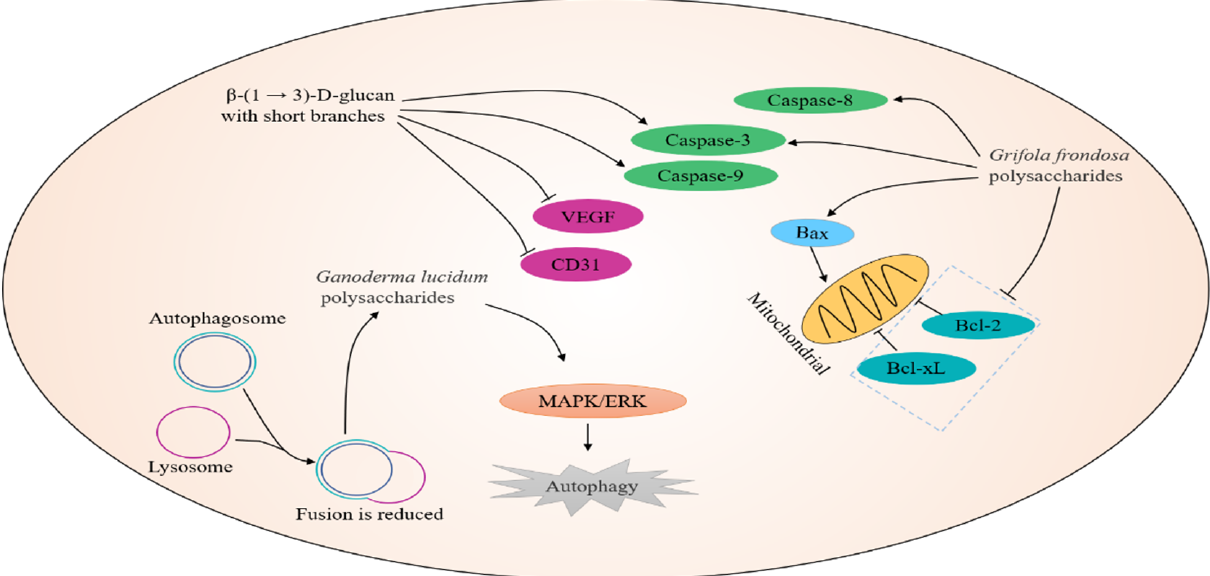
Figure 1. Mechanisms in terms of apoptosis and autophagy induction by the active ingredients of edible and medicinal fungi. Reduced fusion of autophagosomes and lysosomes leads to the induction of autophagy by Ganoderma lucidum polysaccharides through MAPK/ERK pathway. Grifola frondosa polysaccharides-incubated breast cancer cells exhibit an increased level of Bax, caspase-3, caspase-8, and a decreased expression of Bcl-2 and Bcl-xL. β -(1 → 3)-D-glucan with short branches inhibits the growth and induces the apoptosis of HCC cell line H22 by increasing caspase-3/9 levels and decreasing VEGF and CD31 levels.